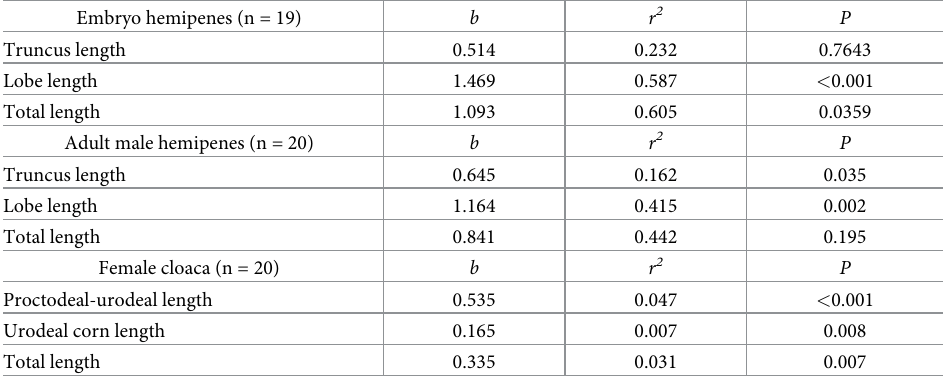
Proctodeal-urodeal length Urodeal corn length Allometric coefficient ( b ), coefficients of determination ( r 2 ) and significance deviation from a slope of one ( P